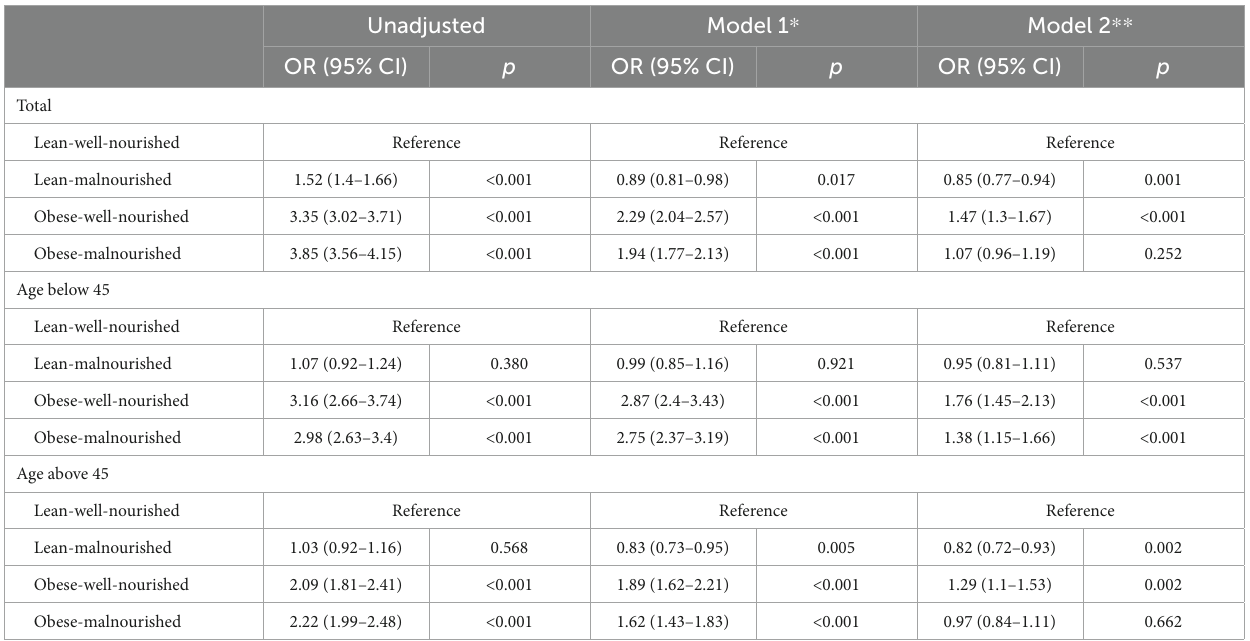
TABLE 2 The association of obesity and malnutrition with the prevalence of hypertension.